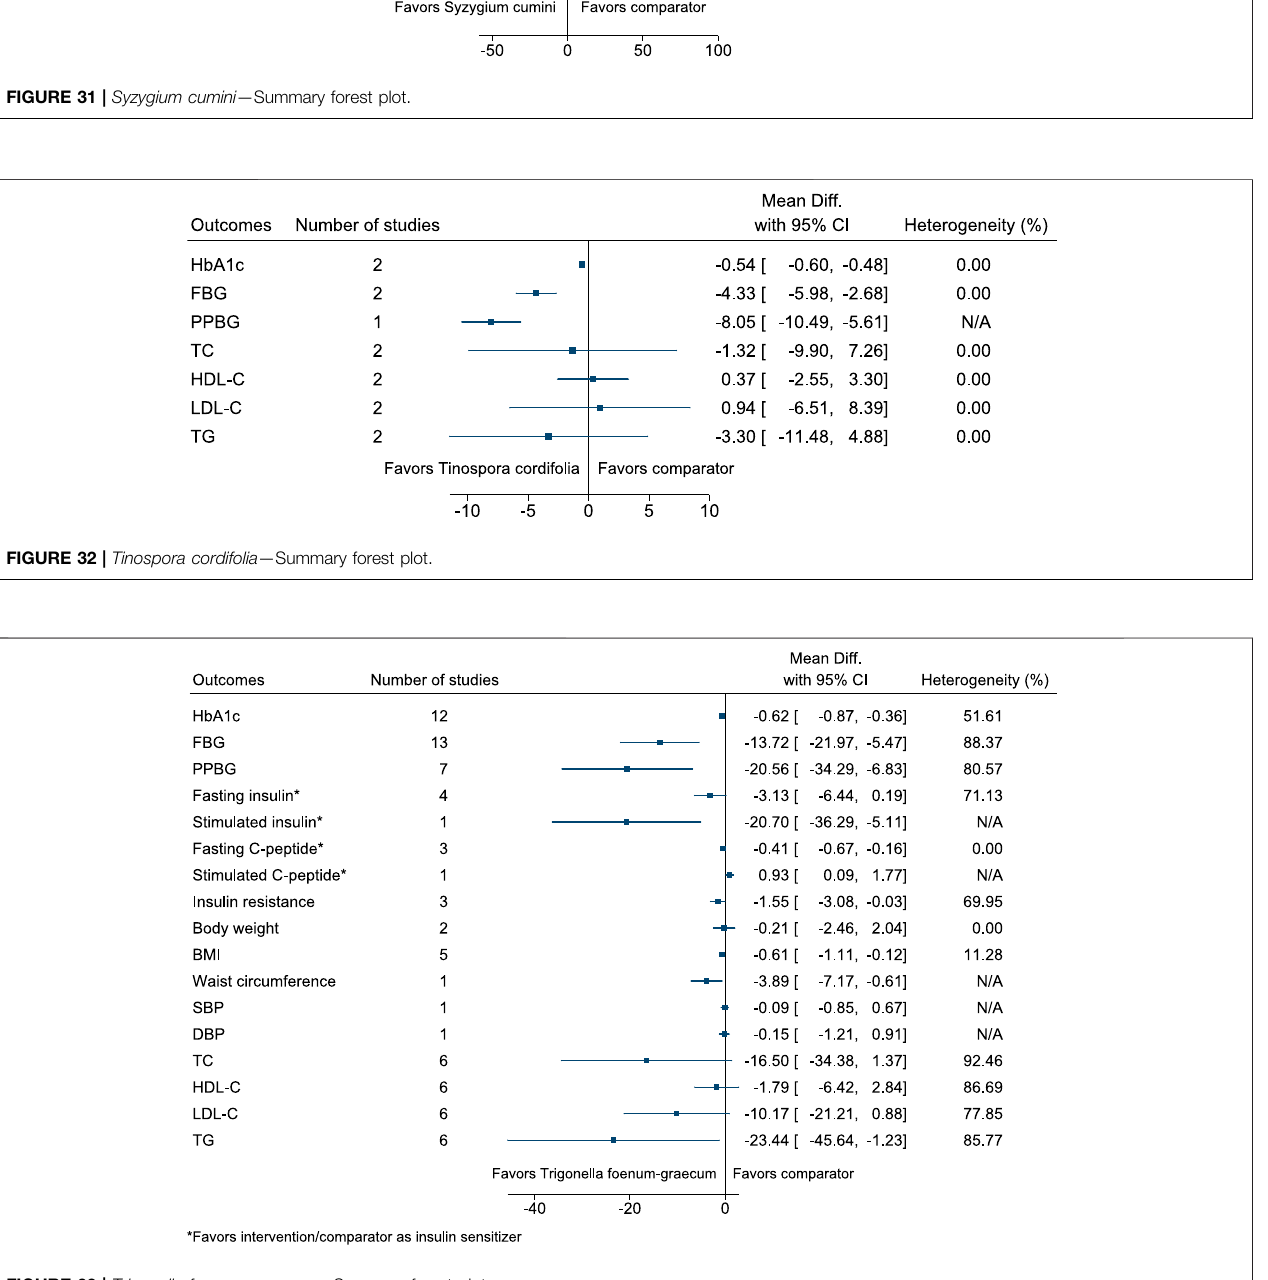
FIGURE 33 | Trigonella foenum-graecum — Summary forest plot.